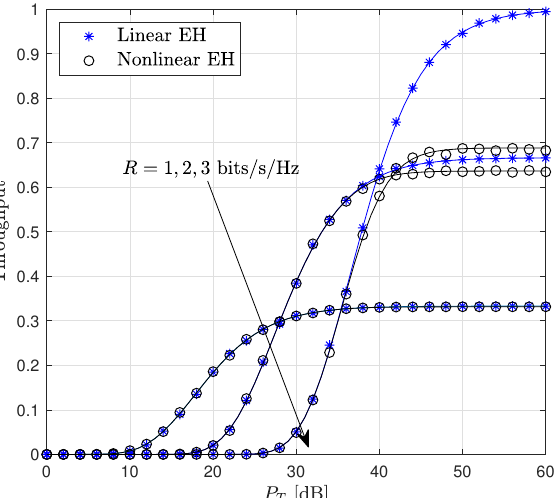
Figure 7. Throughput performance of the WP DH AF relaying system versus P T ( d sd = 1, P th = 35 dB).